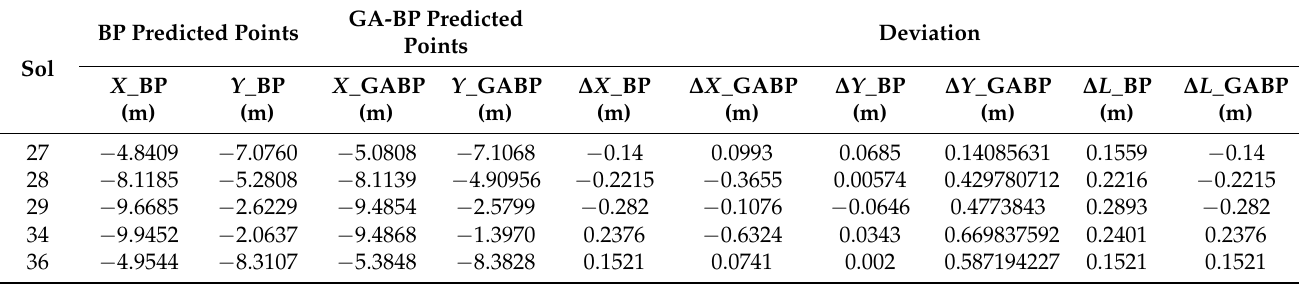
Table 5. BP and GA-BP predicted end points of path.